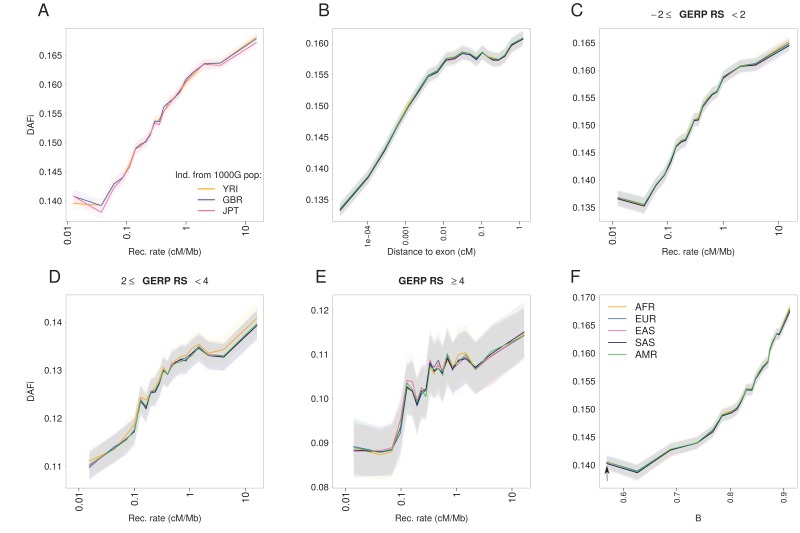
DAFi¯ as a function of various genomic predictors for the 1000G dataset.(A) DAFi¯ as a function of recombination rate for random individuals from three different populations. The same filtering criteria were used as in Figure 1A. (B) DAFi¯ as a function of the recombination distance to the nearest exon. Non-exonic SNPs in our 1000G dataset were classified according to their distance to the nearest exonic region in centiMorgans into 20 equal-size bins. Individuals are grouped by geographic region as in Figure 1A. The vertical dashed line denotes a distance 0.01 cM. C—E) DAFi¯ as a function of recombination rate for mutations associated with different GERP RS conservation scores. (C) SNPs considered as neutral (–2≤GERP RS<2) (D) SNPs with slightly deleterious mutations (2≤GERP RS<4) (E) SNPs with deleterious mutations (GERP RS >4). (F) Relationship between the average B-statistic and DAFi¯ for SNPs for which an estimate of B is available. Both statistics are computed in 20 bins defined as in Figure 1A. The solid lines link the 20 bins from the lowest to the highest recombination rate and the black arrow indicates the bin of SNPs with the lowest average recombination rates. In all panels, shaded areas represent the 95% confidence interval estimated using a block-bootstrap approach (see Materials and methods).